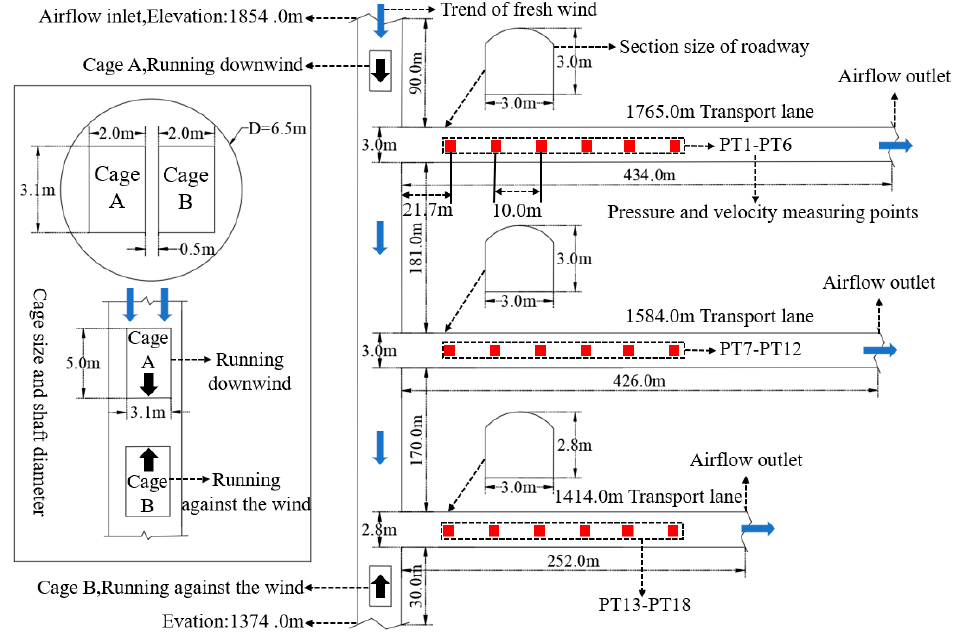
Figure 1. Model size diagram.